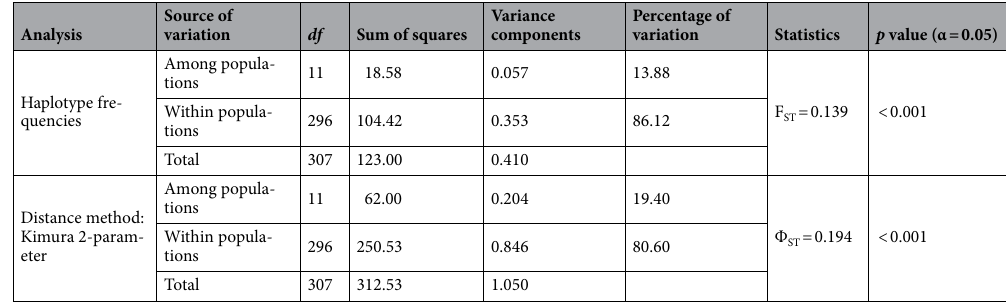
Table 2. AMOVA statistics for mitochondrial DNA control region sequences from Commerson’s dolphin ( Cephalorhynchus commersonii ) distribution along Southwestern Atlantic Ocean.